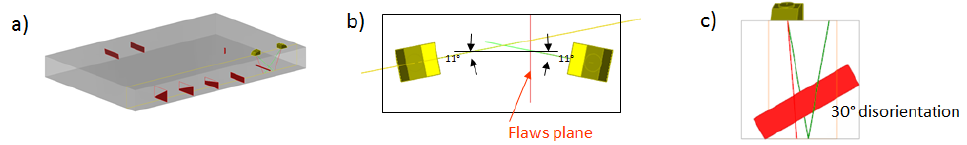
Figure 10. ( a ) A planar component containing disoriented backwall breaking flaws and a 2 mm diameter SDH; the TOFD configuration with the 11° probes’ skew: ( b ) top view and ( c ) side view showing the flaw used for simulating the top edge of the 30° disoriented notch.